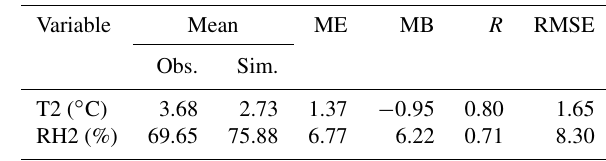
Table 1. Verification statistics of daily temperature at a height of 2m (T2), and relatively humidity at a height of 2m (RH2). “Obs.” denotes observations, and “Sim.” denotes simulated